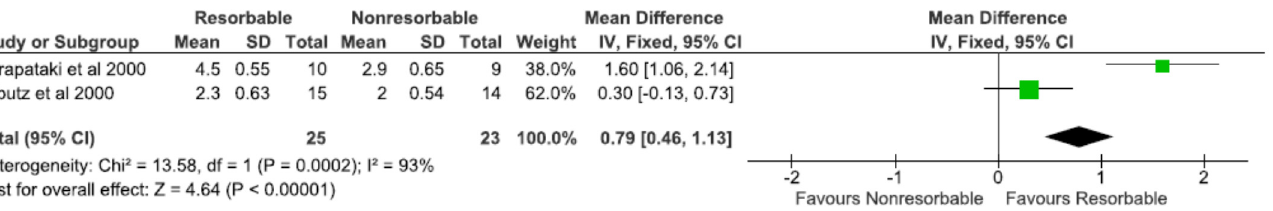
Figure 11. Meta-analysis of intra-bony defect depth (IBDD) at 12